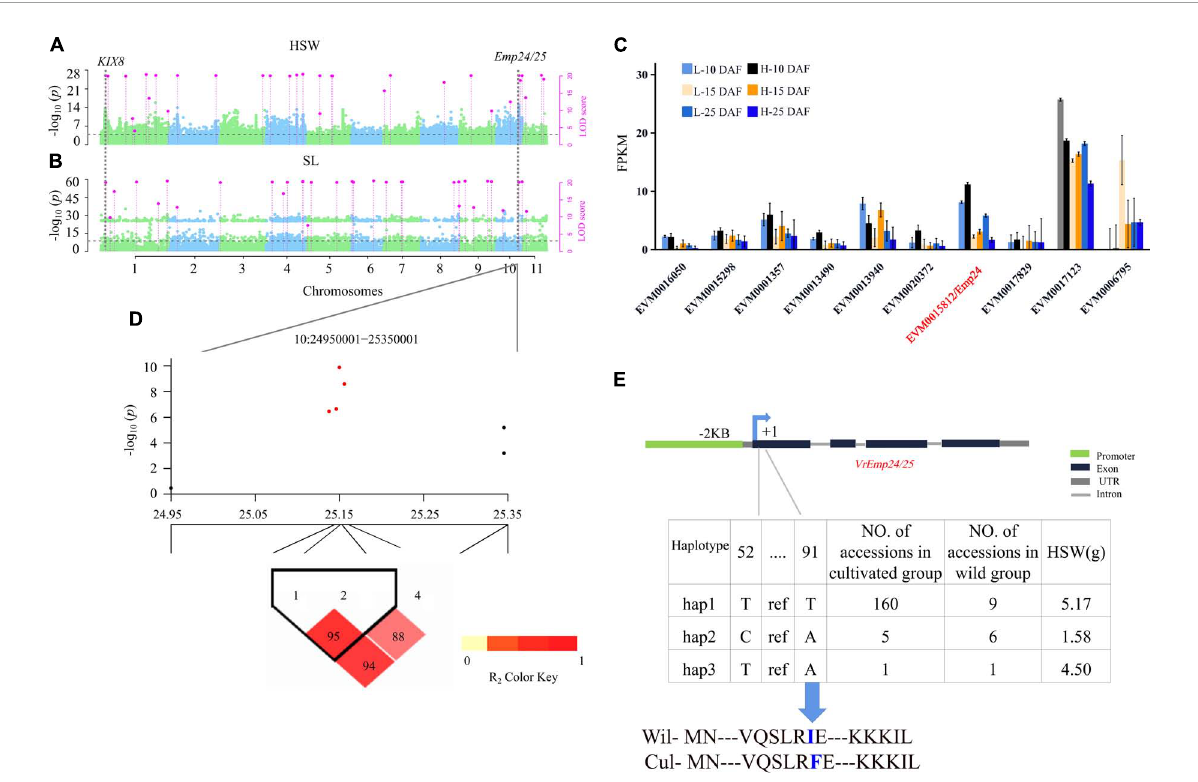
FIGURE4 Genetic analysis of VrEmp24/25 . Local Manhattan plots for HSW under multi-environments. LOD ≥ 3.0 for the 3VmrMLM as the significant QTN (A,B) . The expression profiling of 10 candidate genes for HSW identified at 30 Kb around Chr10-25222572-25223133 loci in the seed between two high-seed-weight and two low-seed-weight mungbeans (C) . LD heatmaps surrounding Chr10-25222572-25223133 loci (D) . Haplotype analysis of VrEmp24/25 (E) , the thirtieth amino acid of VrEmp24/25 changed from ATT (Ile, I) to TTT (Phe, F). DAF, days after flowering. Wil, the wild accessions. Cul, the cultivated